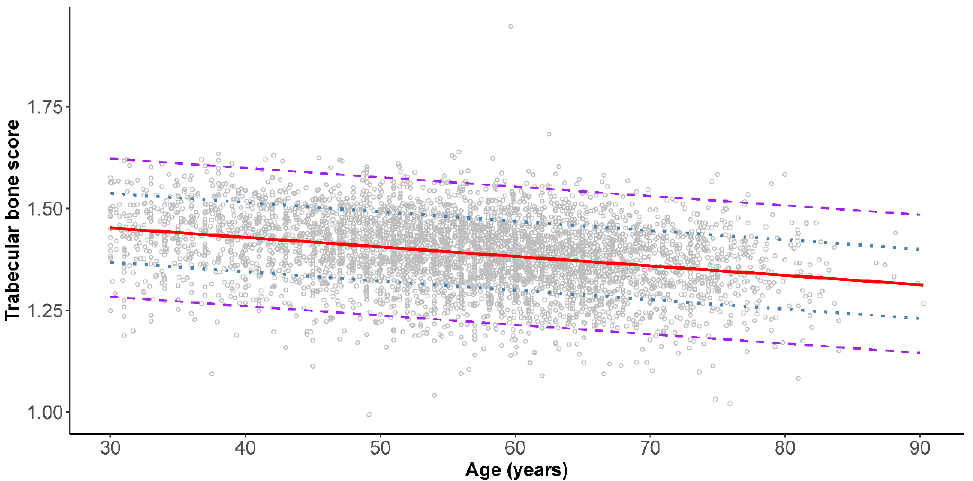
Figure 2. Piecewise linear regression analysis of trabecular bone score and age in male Taiwanese. Solid line (red) represents the piecewise linear regression line. No breakpoints were identified. The dotted (blue) and dashed lines (purple) represent the one and two standard deviation lines, respectively.